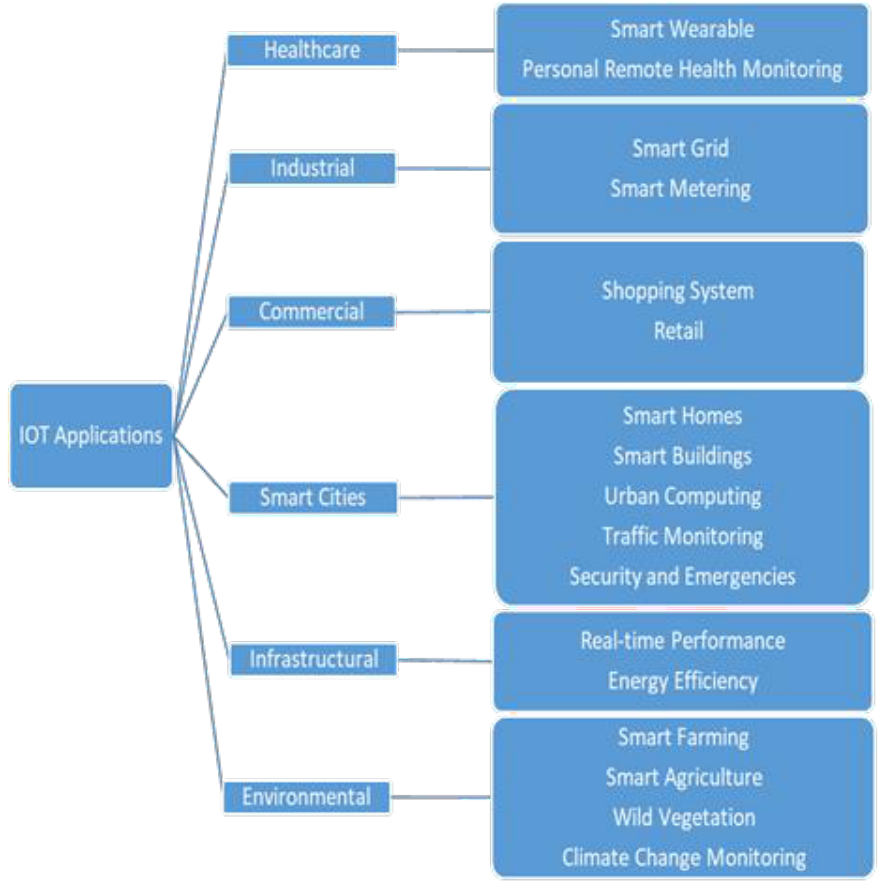
Figure 1. Taxonomy of IoT Applications [4].